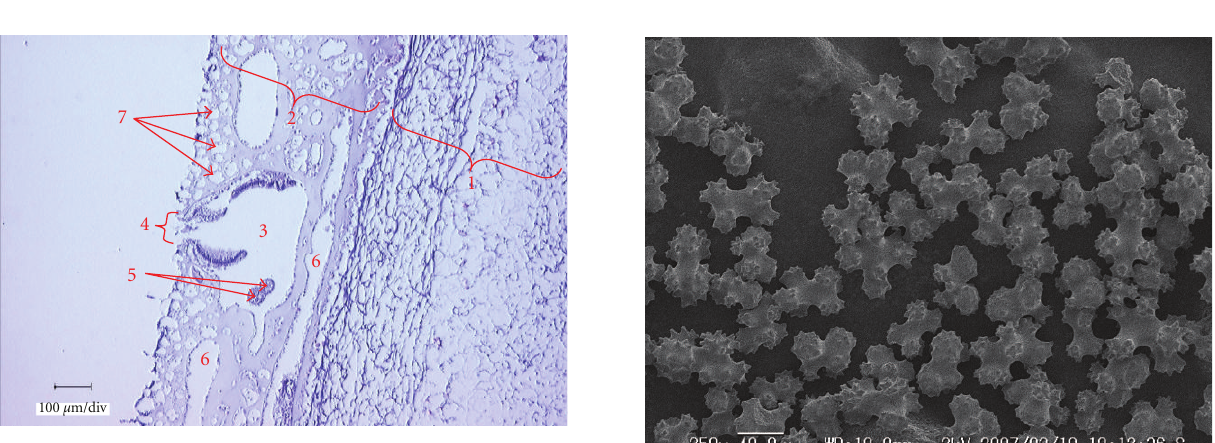
Figure 17: Histological section of Corallium elatius ; OCA- Cn20071202-007. 1: axis, 2: coenenchyme, 3: siphonozooid, 4: siphonozood’s opening, 5: gamete (sperm sac), 6: vascular canals, 7: sclerite’s openings.